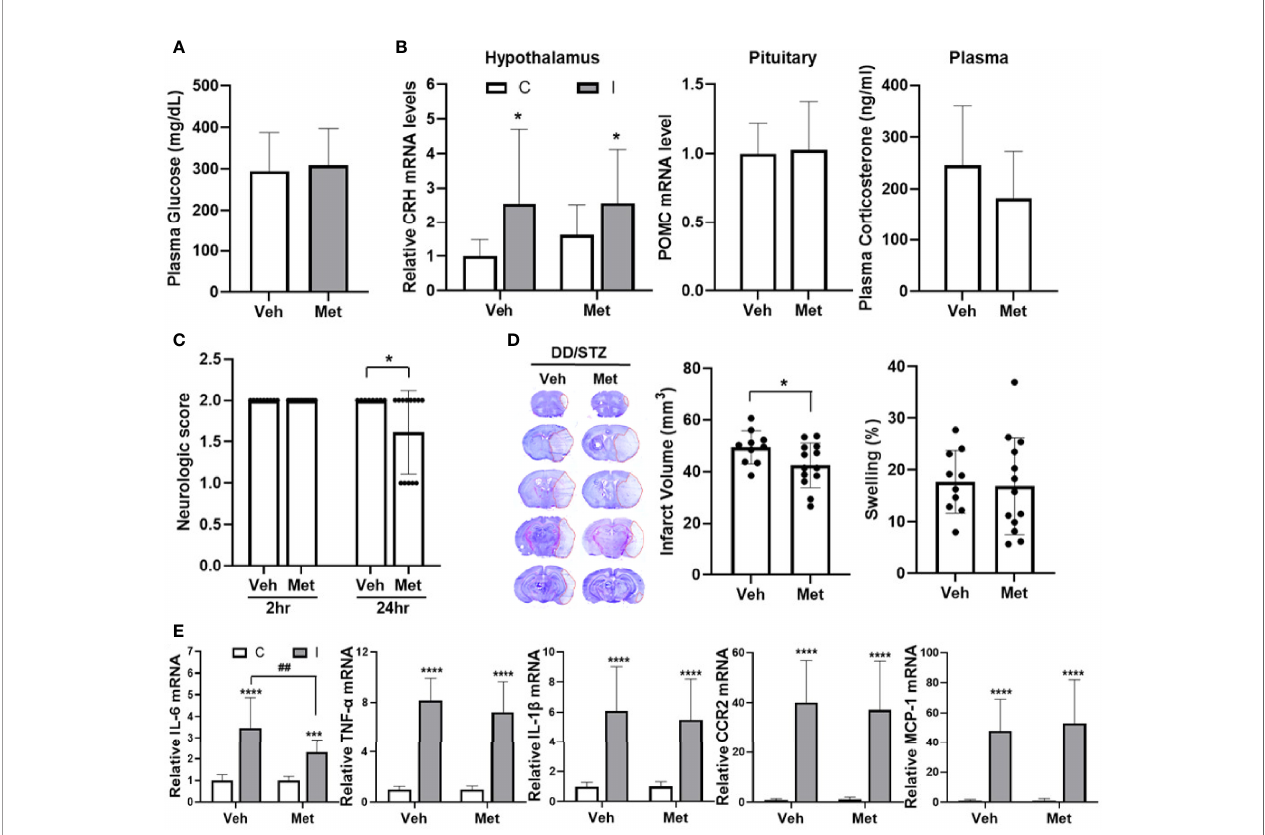
FIGURE 4 | Reduce ischemic injury in diabetic mice by inhibition of GC synthesis. Mice were treated with either vehicle (veh) or metyrapone (100 mg/kg) by intraperitoneal (i.p.) injection daily for 3 days after ischemic stroke. (A) Plasma glucose levels. Glucose levels were determined by a glucometer in the plasma isolated from trunk blood at 3 days post-stroke. (B) Gene expression of CRH and POMC in the hypothalamus and pituitary, and plasma corticosterone levels. Each gene expression level was normalized by GAPDH. The mean value of contralateral of veh (hypothalamus) or veh (pituitary) was regarded as 1, and we calculated the relative values for the others. Plasma corticosterone levels were measured in the diabetic mice at 3 days post-stroke. Data are presented as mean ± SD. (C) Neurological scores in DD/STZ mice treated with veh or metyrapone. (D) Infarct volume and swelling were measured in coronal section mouse brains. Data are presented as mean ± SD. * p < 0.05 vs. Veh, Student ’ s t -test. (E) Gene expression of in fl ammatory mediators in the mouse brain at 3 days post-stroke. Each gene expression level was normalized by GAPDH. The mean value of contralateral of veh was regarded as 1, and we calculated the relative values for the others. n = 10 – 13/group (10 for vehicle, 13 for metyrapone). Data are presented as mean ± SD, *** p < 0.001, **** p < 0.0001 vs. C; ## p < 0.01 vs. I of Veh, two-way ANOVA; C, contralateral; I, ipsilateral. Veh, DD/STZ mice treated with veh; Met, DD/STZ mice treated with